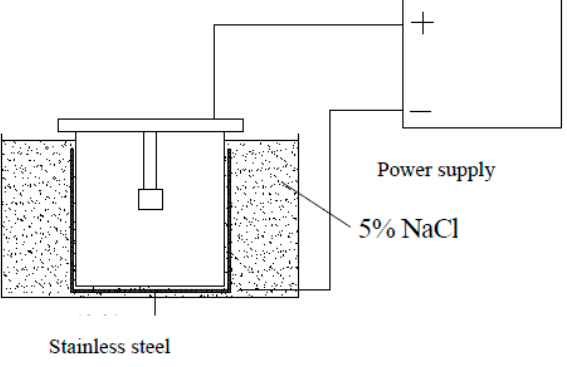
Figure 2. Setup of the electronic accelerating corrosion. Table 3. Expected stud corrosion rate and actual corrosion time of the 10.0 mm series.